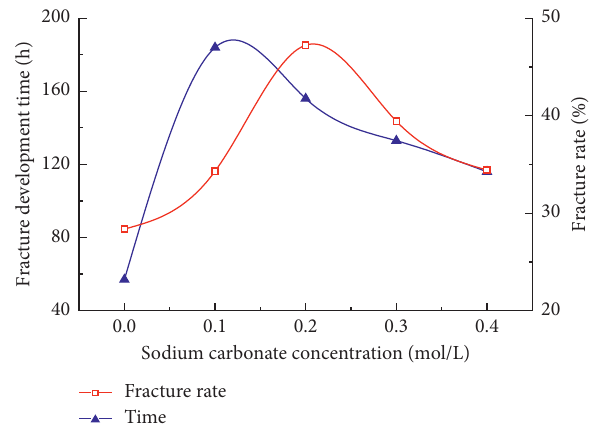
Figure 7: Relationship between the sodium carbonate concen- tration and the